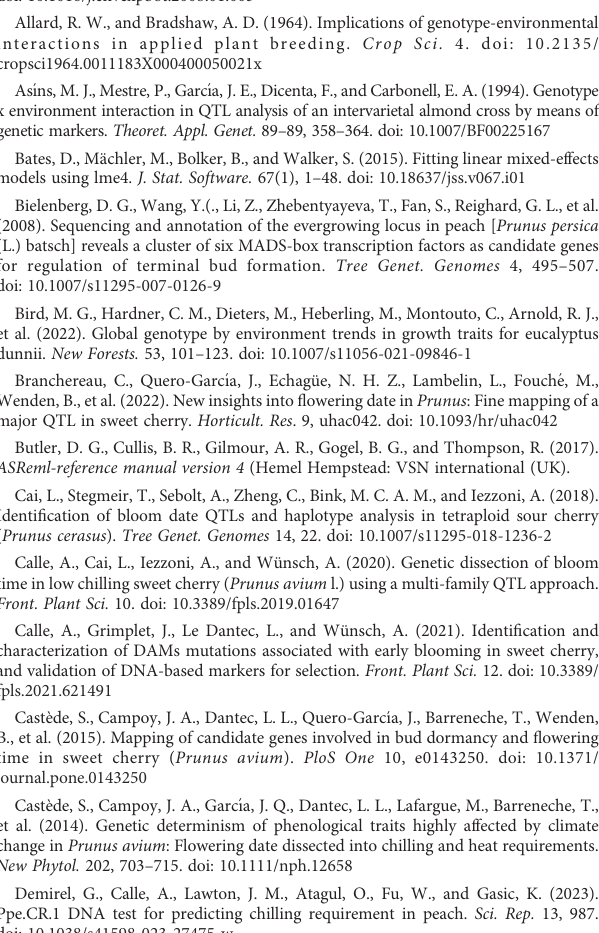
SUPPLEMENTARY FIGURE 4 TemperaturedeviationtothemeaninNimesin2017,2018,2019 and2021 for the period spanning from October to April. The mean was calculated using the temperature data from 2010 to 2021. SUPPLEMENTARY FIGURE 5 Temperature deviation to the mean in Toulenne in 2016, 2017, 2018, 2019 and 2021 for the period spanning from October to April. The mean was calculated using the temperature data from 2010 to 2021. SUPPLEMENTARY FIGURE 6 Reaction norms for Beginning of Flowering (BF) across years in each location of study. Norm of reaction of each R×L hybrid is shown by a line. SUPPLEMENTARY FIGURE 7 Representation of the PVE values of QTL on LG R4 obtained with the multi- location — multi-year analysis as a function of the mean temperature for the period from October to February. SUPPLEMENTARY FIGURE 8 Representation of the PVE values of QTL on LG L1 obtained with the multi- location — multi-year analysis as a function of the mean temperature for the period from October to